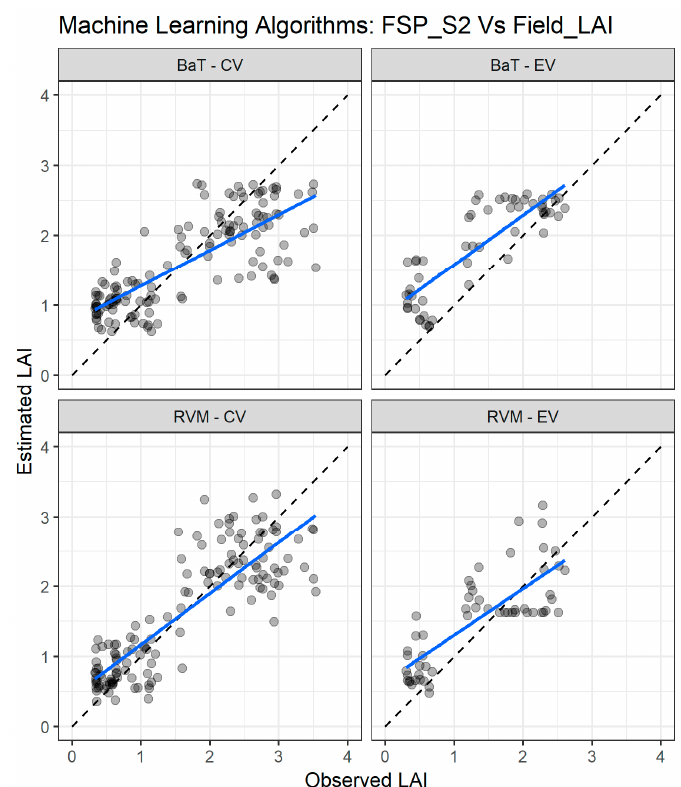
Figure 10. Comparisons of the LAI measured and estimated with the two best performing machine learning regression algorithms (MLRA) using the field spectra resampled to Sentinel-2 bands (FSP_S2). CV—cross validation, EV—external validation. RVM—relevance vector machine; BaT—bagging tree. The blue line depicts the linear regression and the black dashed line the linear regression through origin.